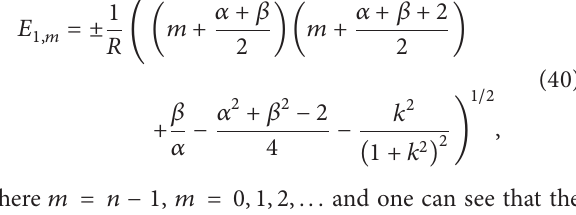
Figure 2: The graphs of (a) component of the vector potential 𝐴 𝑢 (𝑤) in (29), effective models (b) 𝑉 energy 𝐸 1,𝑛 in (40). The effective potential well 𝑉